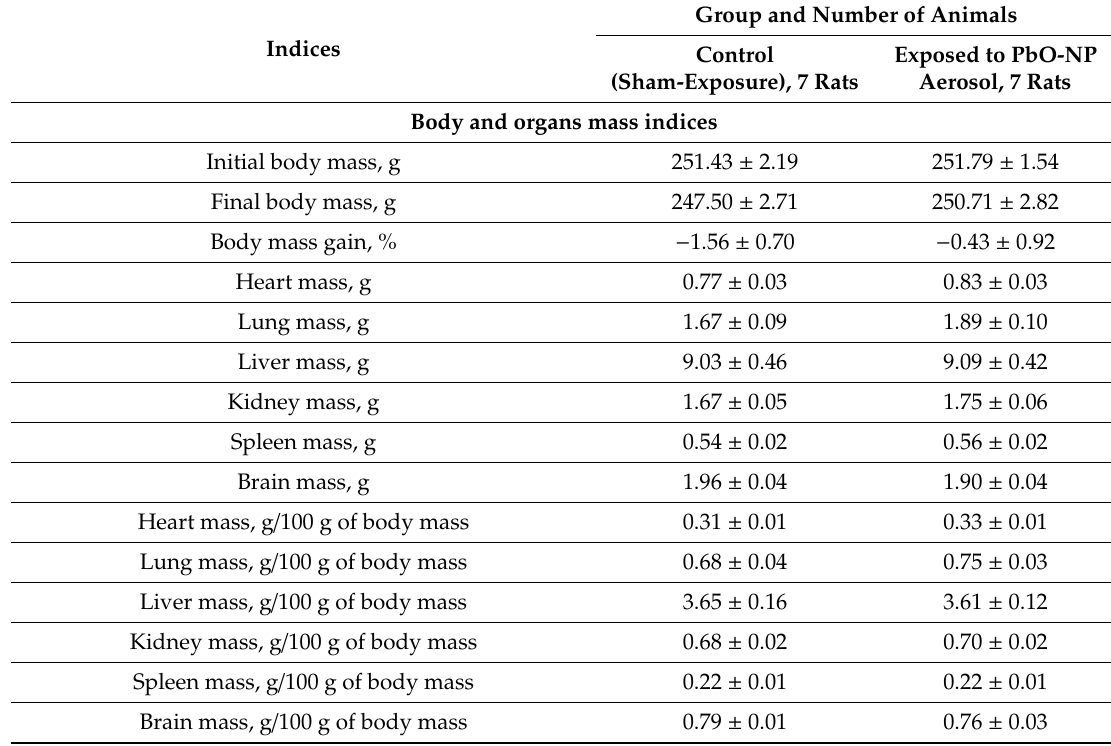
Table 3. Body and inner organs mass and some functional indices in rats after repeated inhalation of lead oxide nanoparticles (x ±